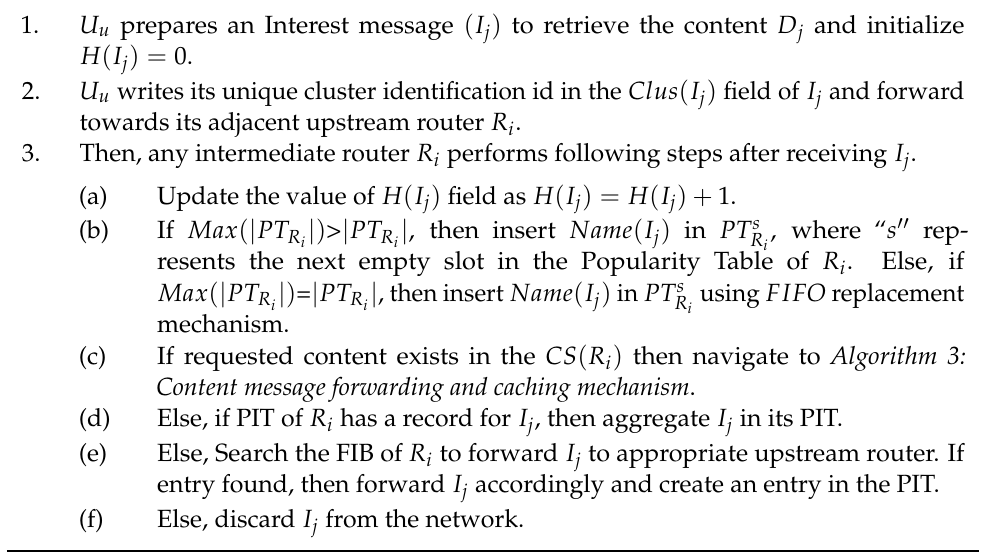
Algorithm 2: Interest message forwarding mechanism ( U u , I j , R i , R m